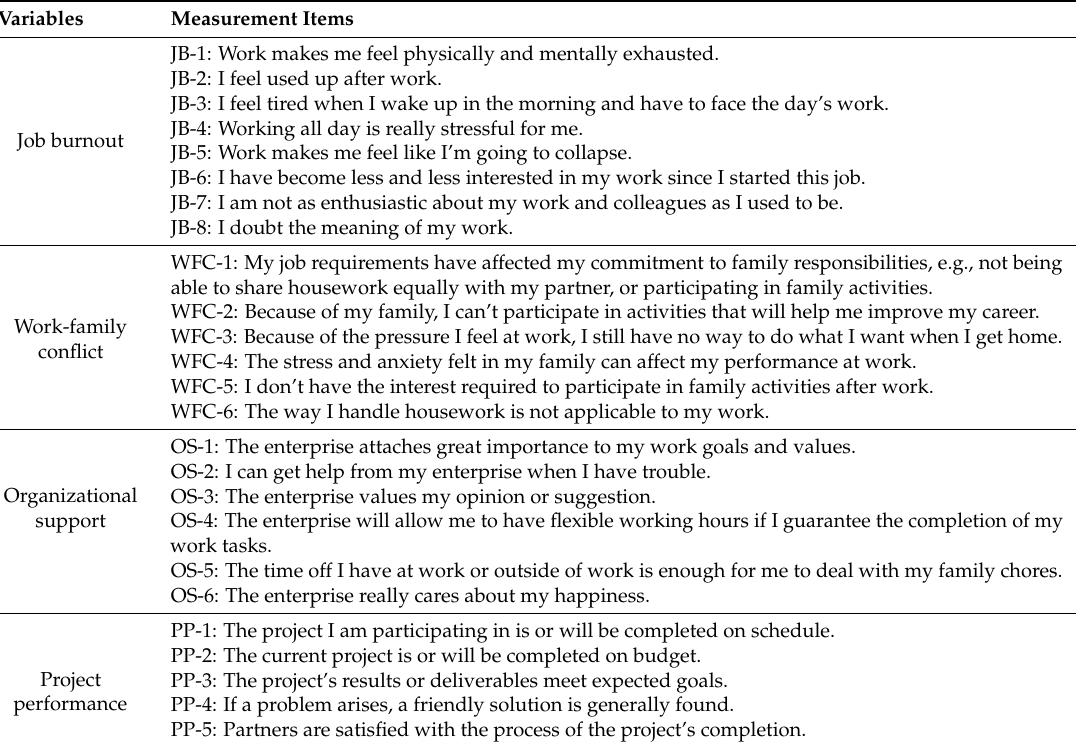
Table 1. Measurements for job burnout, WFC, organizational support and project performance.